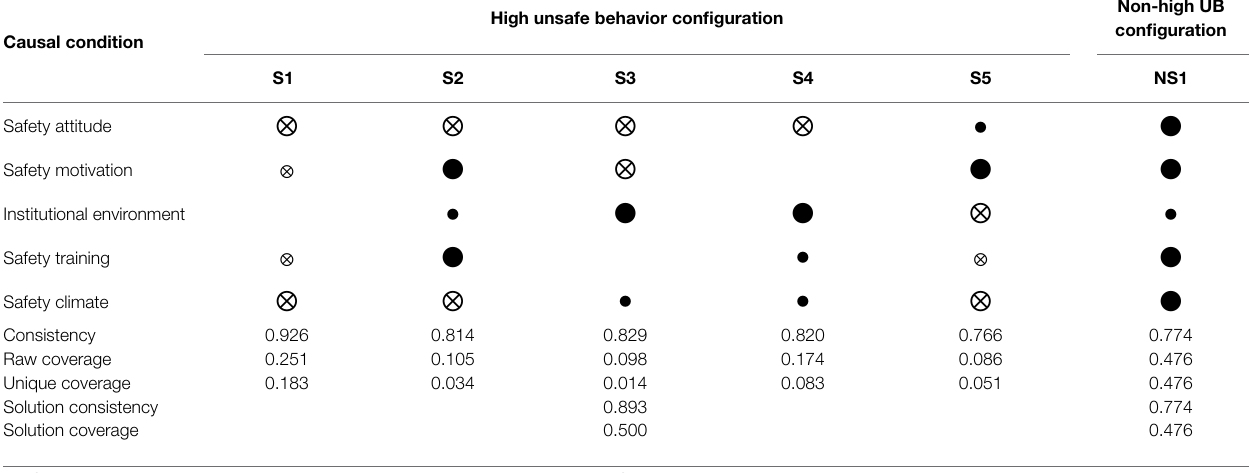
TABLE 10 | Configuration of high and non-high construction workers’ safety behavior.